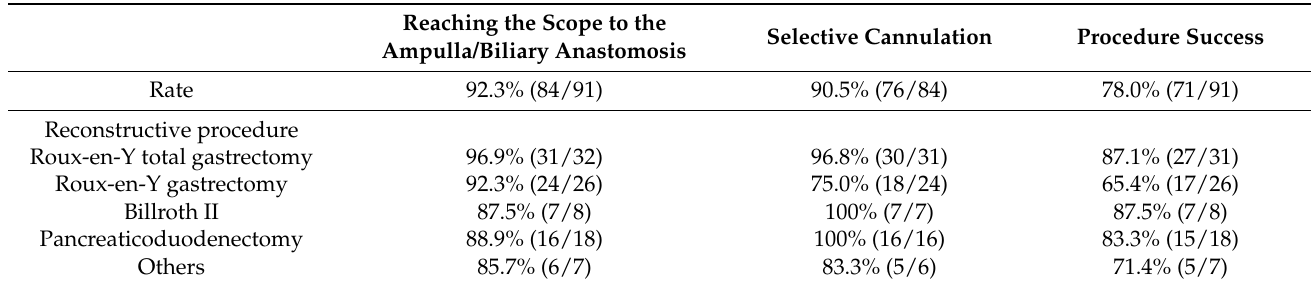
Table 2. Associations of anatomy with success rate of enteroscopy, cannulation, and procedure.